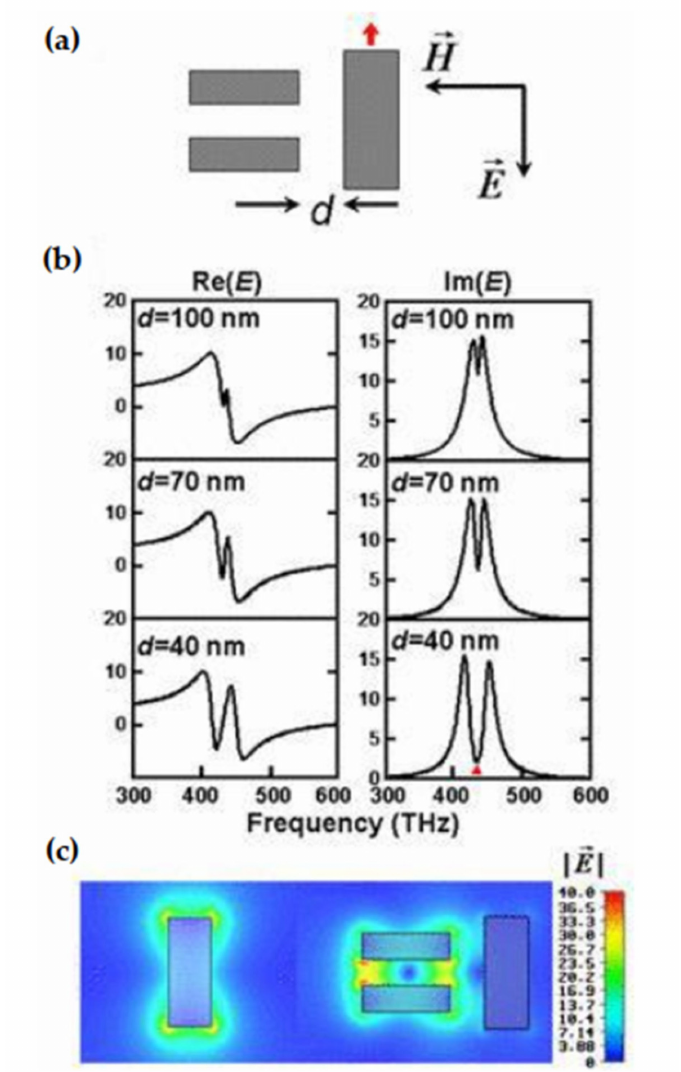
Figure 21. ( a ) Top view of the plasmonic system consisting of a radiative element and a dark element with separation d, with light incident at the normal direction. ( b ) The real part and imaginary part of an E x probe placed at 10 nm from the end facet of the radiative antenna red arrow in ( a ) for separations ranging from 40 to 100 nm between the radiative and dark elements. ( c ) The 2D field plot of an uncoupled radiative atom ( left ) and radiative atom coupled with a dark atom with a separation of 40 nm ( right ) at a frequency of 428.4 THz, as indicated by the red triangle in ( b ). Reprinted with permission from Ref. [202] Copyright 2008 American Physical